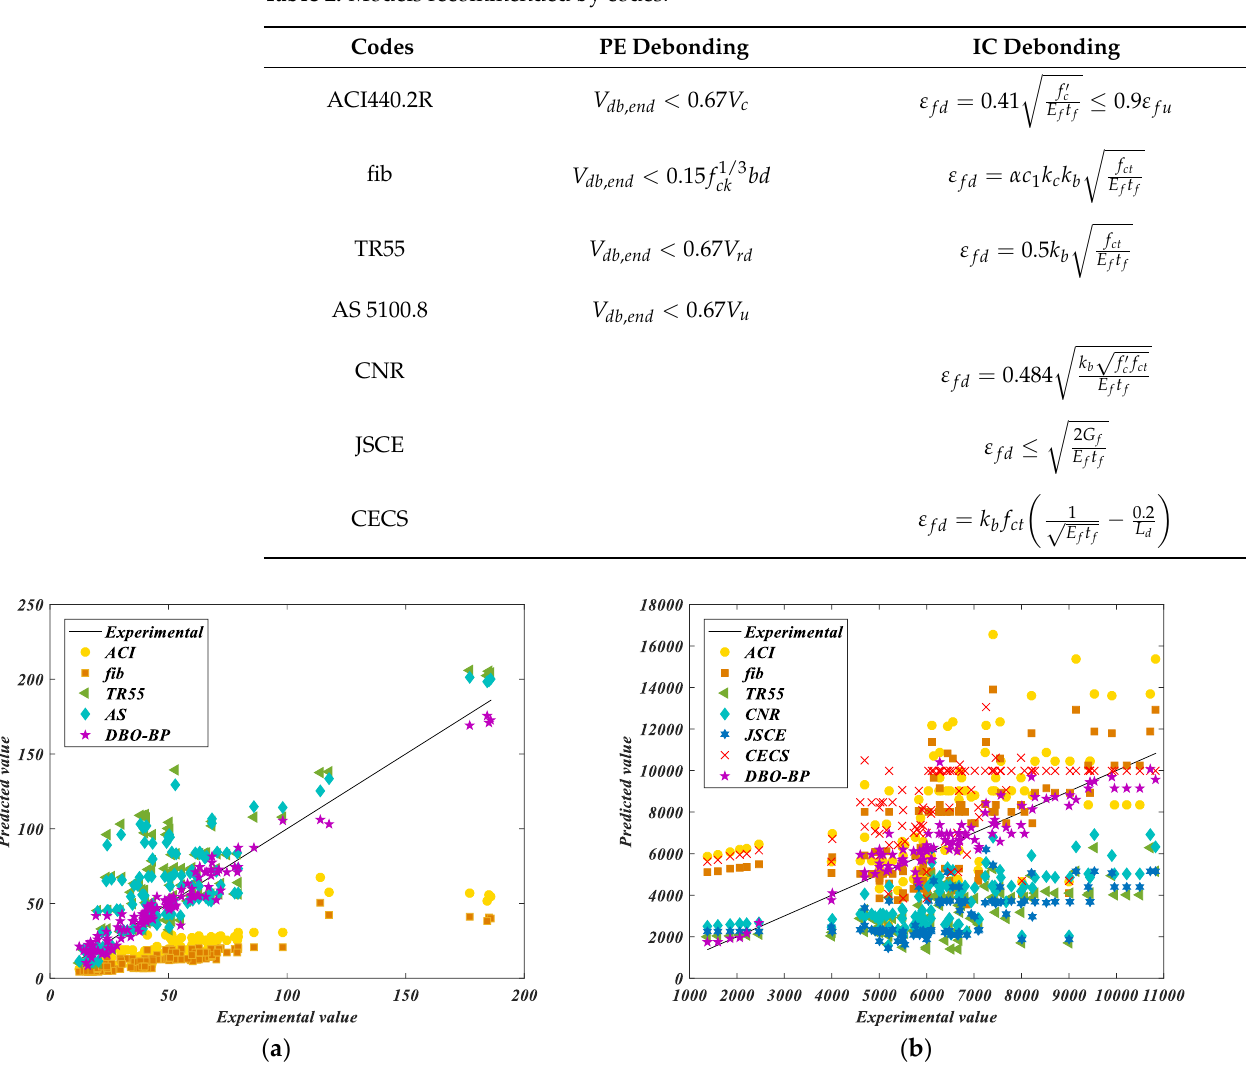
Table 2. Models recommended by codes.